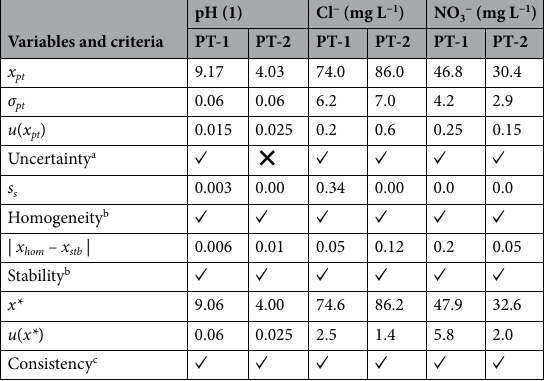
Table 1. Main results of the project design and evaluation criteria for PTs in the cooperation project. ✓ , Meets criterion; ❌ , Does not meet criterion. a According to Eq. (3). b According to ISO 13528:2015. c According to Eq.